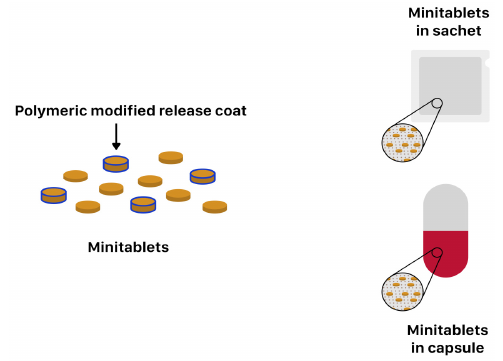
Figure 9. Scheme illustration of minitablets placed in capsule and sachet.